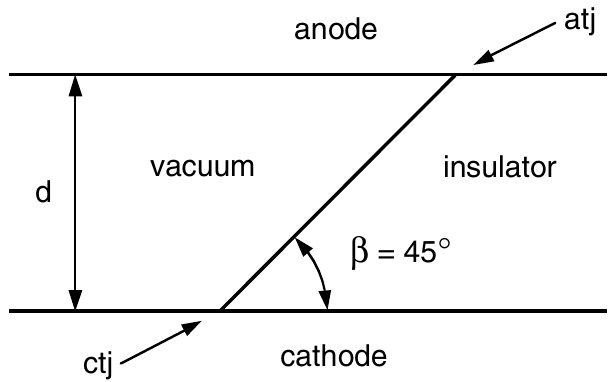
FIG. 1. Idealized 2D 45 (cid:1) vacuum-insulator interface. The anode triple junction (atj) is the point at which the vacuum, insulator, and anode regions meet; the cathode triple junction (ctj) is similarly